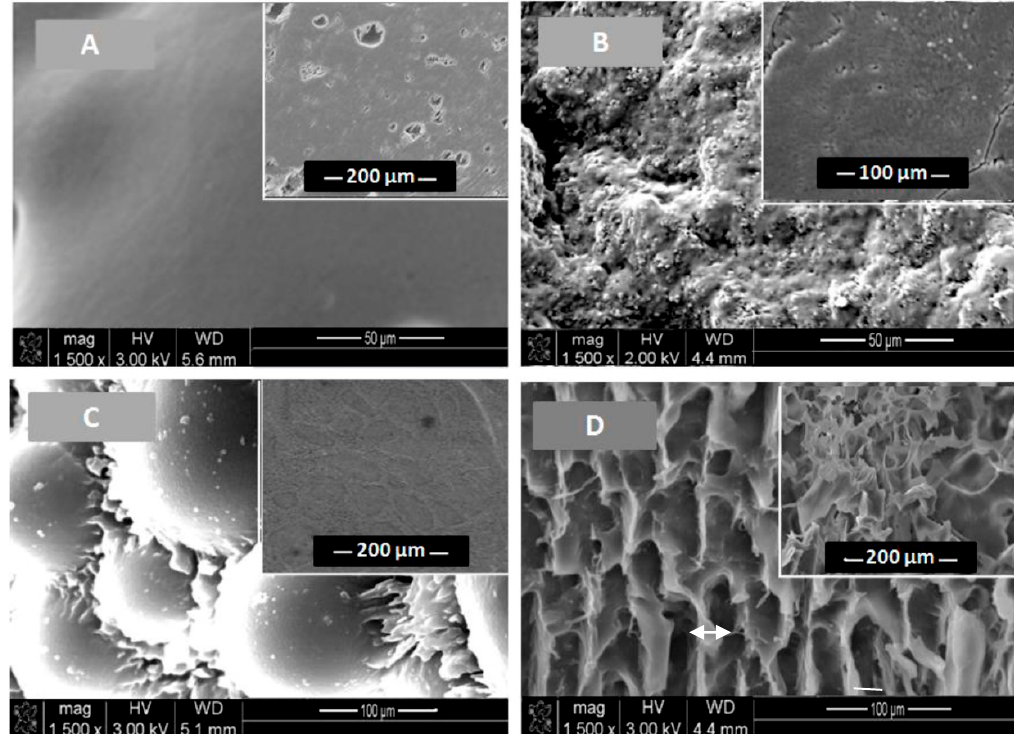
Figure 8. SEM micrographs of: ( A ) surface morphology of P δ -VL film and its cross-sectional morphology(in right in the top); ( B ) surface morphology of P δ -VL/TiO 2 -1 film and cross-sectional morphology (in the right in the top); ( C ) surface morphology of P δ -VL/TiO 2 -1/ Naph and its cross-sectional morphology ( in the right in the top) before removing the porogen; and ( D ) surface morphology of P δ -VL/TiO 2 -1/Naph film and its cross-sectional morphology (top right) of P δ -VL/TiO 2 -1/ Naph film after removing the porogen then pores connection.